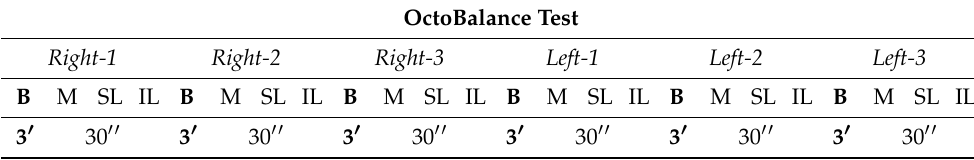
Table 3. Chronogram of the OB